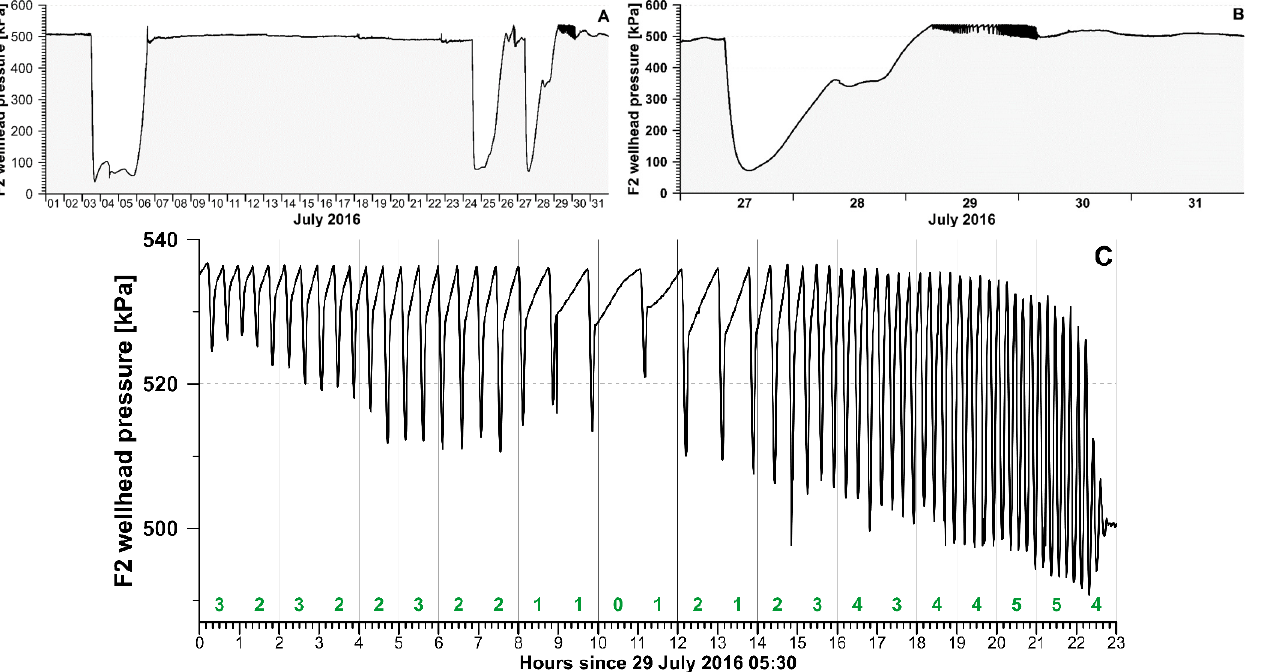
Figure 12. Wellhead pressure excursions at F2 ( A ) during July 2016, ( B ) details during 27–31 July 2016, and ( C ) a zoom showing the oscillations which started 29 July 2016 at 05:30 UTC. The green numbers indicate the frequency of the oscillations in cycles per hour.